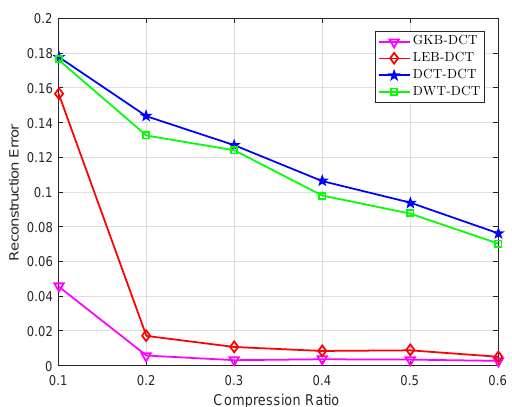
Figure 6. The reconstruction error under different transform